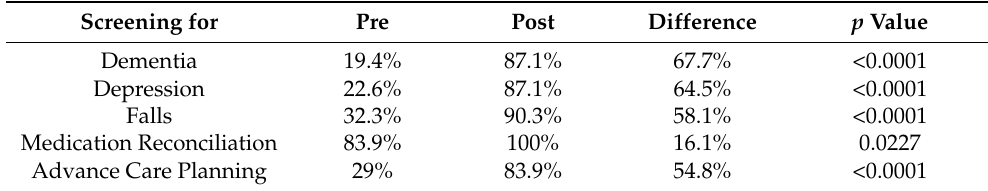
Table 1. Difference in screening for geriatric syndromes before and after participating in the annual wellness visit. ( n = 31 with complete data).